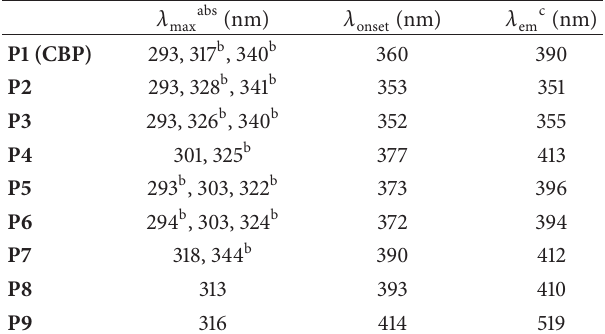
Table 1: UV-Vis: spectroscopic data and fluorescence on 300 nm excitation a